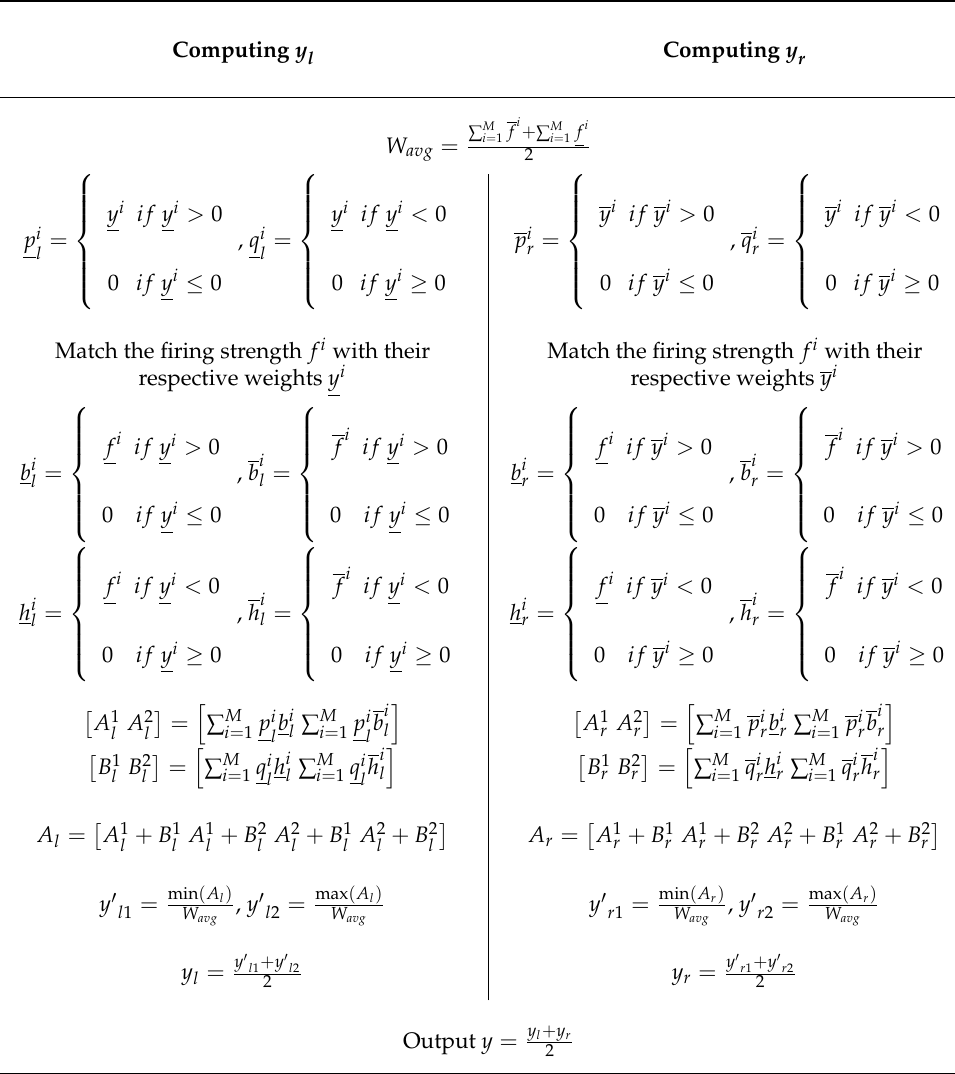
Table 2. The Moradi–Zirhohi–Lin type reduction